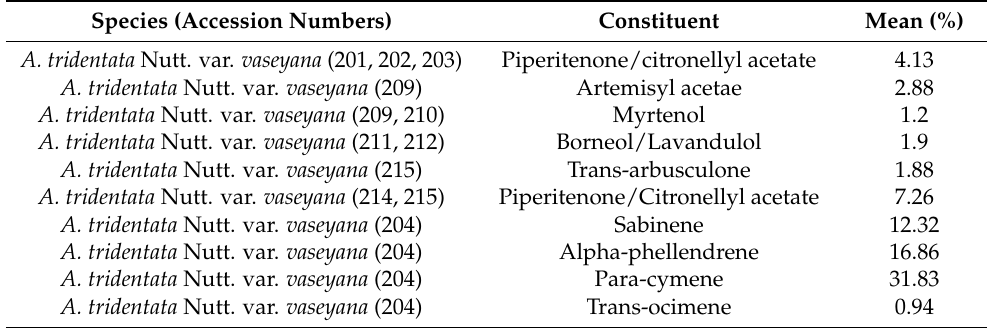
Table 7. Piperitenone/citronellyl acetate, artemisyl acetae, myrtenol, borneol/lavandulol, trans- rbusculone, sabinene, alpha-phellendrene, para-cymene and trans -ocimene that were obtained from only one accession (shown in bracket in Column 1) or without significant difference among accessions.